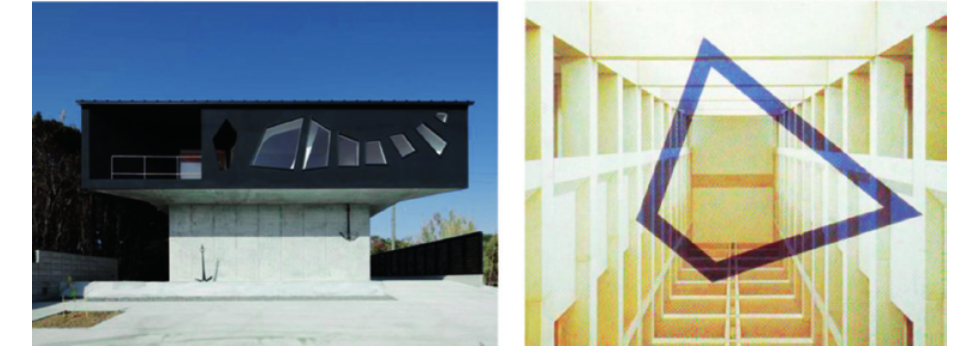
Fig. 13. Eastern Design Office. Fig. 14. Felice Varini. Anamorphic Art